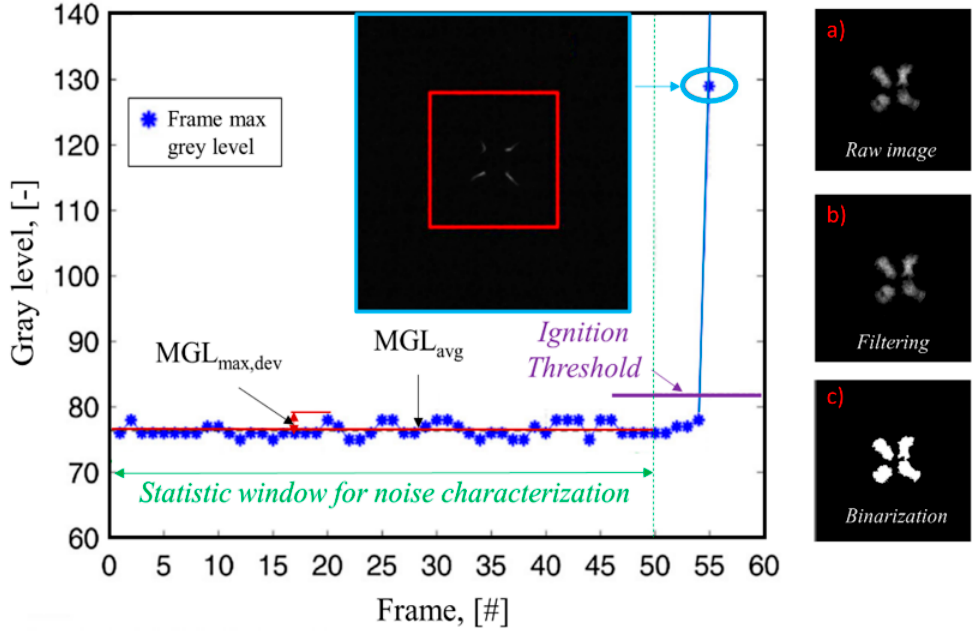
Figure 5. Example of maximum grey level evolution in the statistic window preceding the ignition event (first ignition frame): the red square is the sub-area for ignition detection. The images on the right side display the main steps of the combustion analysis performed on the ( a ) original image, i.e., ( b ) filtering and ( c ) binarization processes.